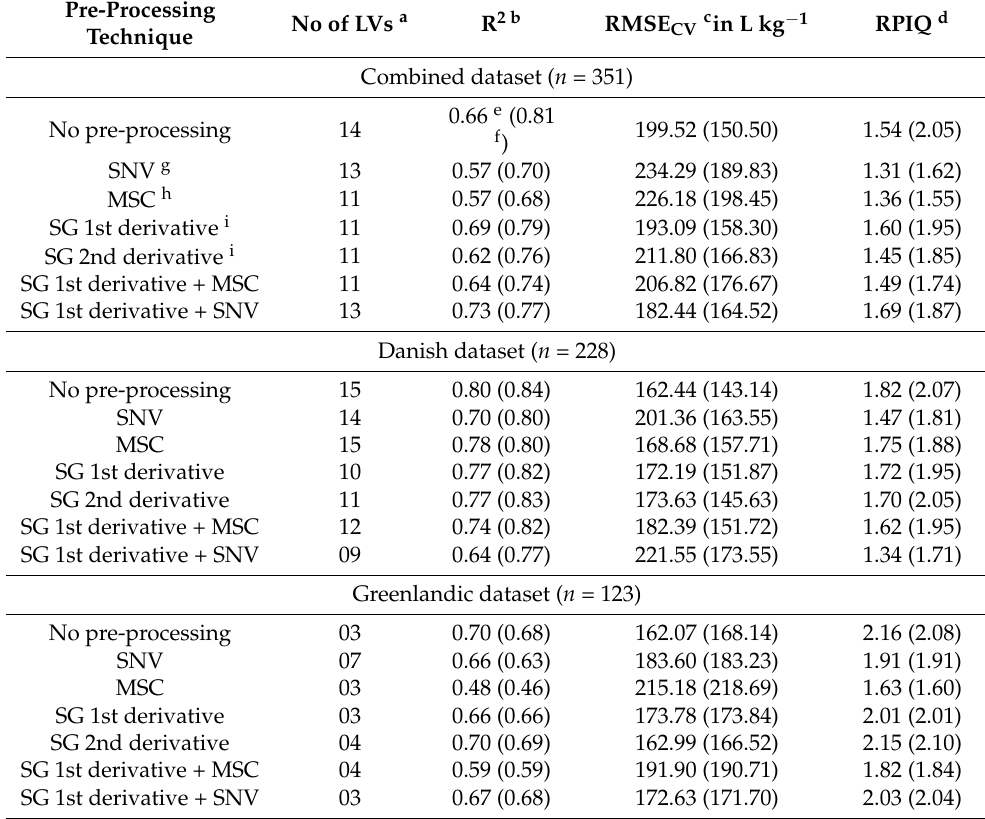
Table 3. The effect of spectral pre-processing on partial least squares regression (PLSR) and artificial neural network (ANN) calibration models of each dataset to predict the K d of glyphosate.